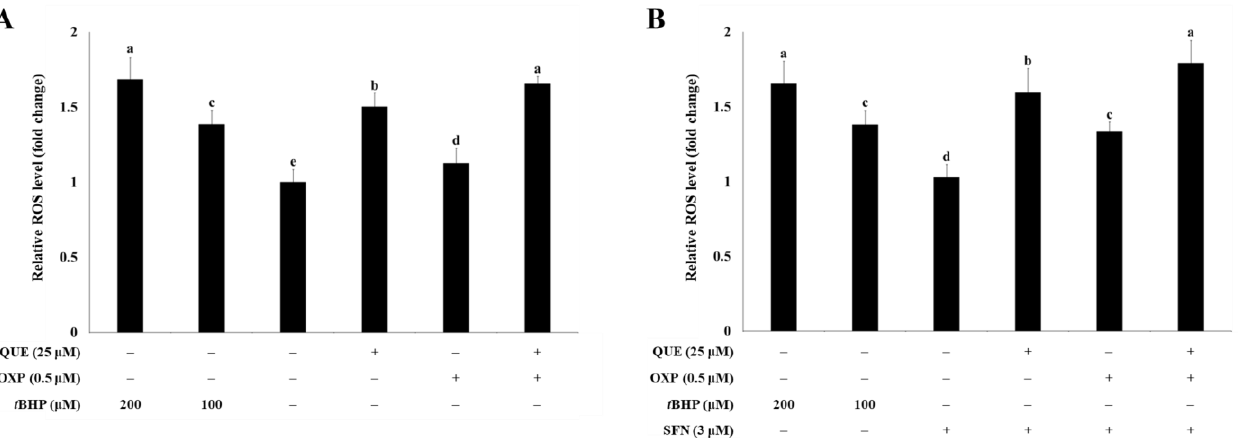
Figure 3. QUE in combination with OXP synergistically increased the ROS level in HCT116 cells. HCT116 cells were plated in a black-bottom 96-well plate at a density of 1 × 10 4 cells per well. After incubating for 24 h, cells were treated with 20 μM H 2 DCFDA for 30 min, followed by incubation with QUE (25 μM), OXP (0.5 μM), both compounds and t BHP (100 μM or 200 μM, a positive control for ROS production) in the absence ( A ) or presence ( B ) of SFN for 30 min. Subsequently, the fluorescence was measured. Error bars, mean ± SEM ( N = 3). Significant differences among the experimental groups are denoted by different alphabetical letters ( p < 0.05, one-way ANOVA with Duncan’s post hoc HSD